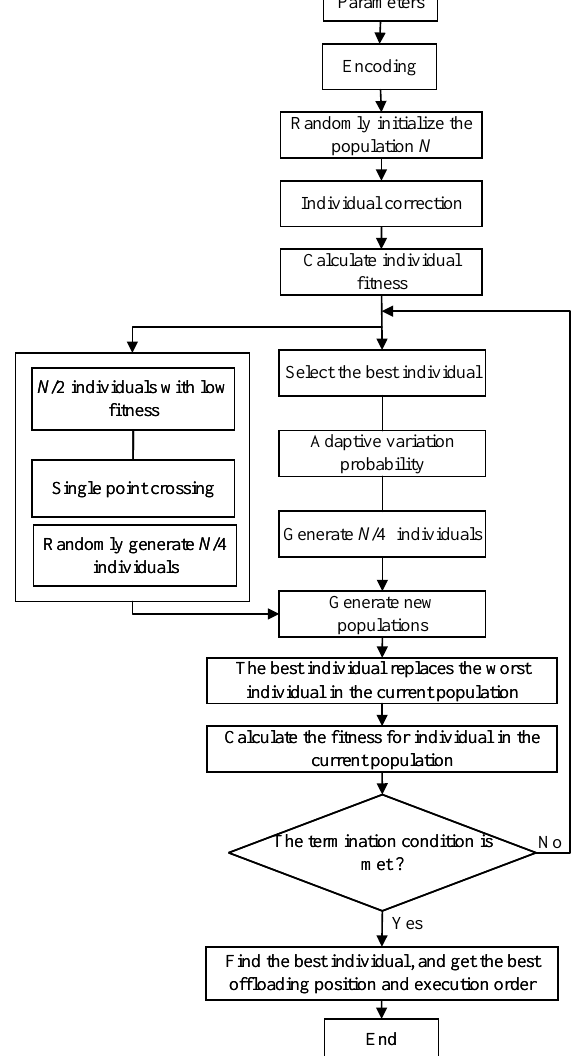
Figure 3. The algorithm flowchart.